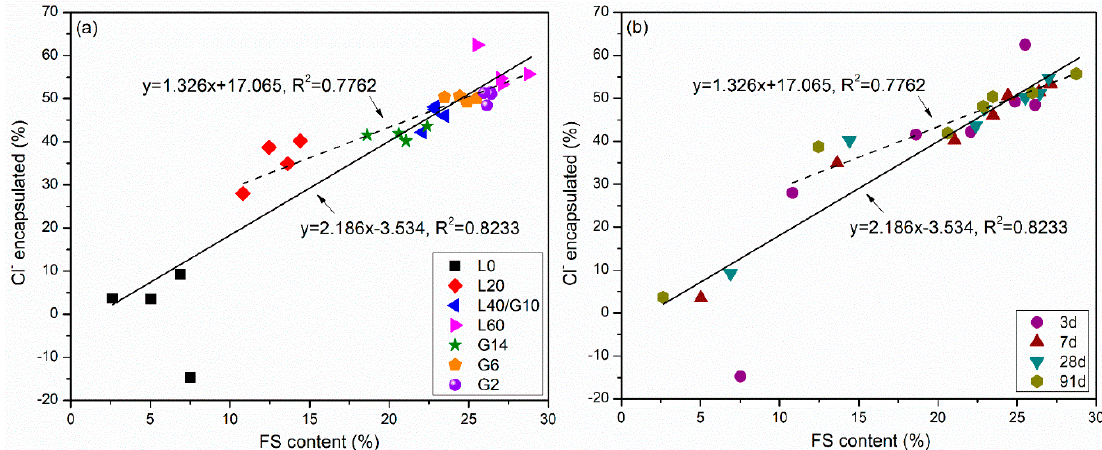
Figure 10. Linear relationship between Cl − encapsulation and Friedel’s salt amounts showing with varying ( a ) group design and ( b ) age of hydration.